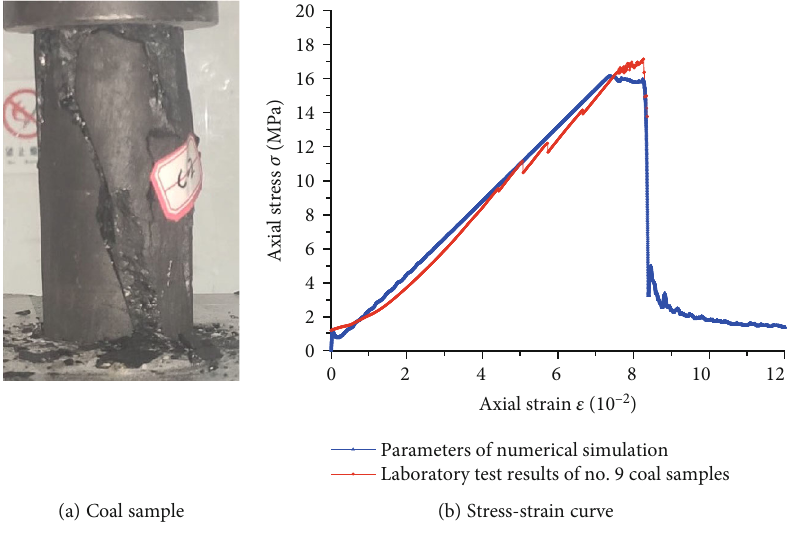
Figure 5: Calibration result of the coal seam simulation parameter. Table 1: Parameters in FLAC3D numerical